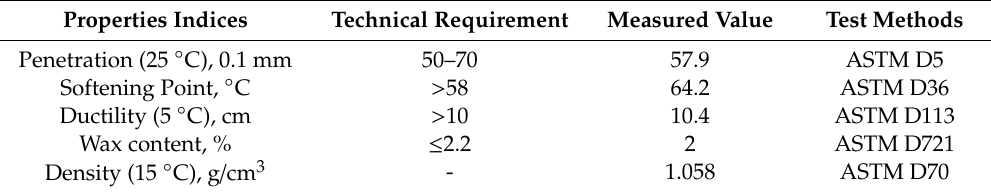
Table 3. Main properties indices of rubber